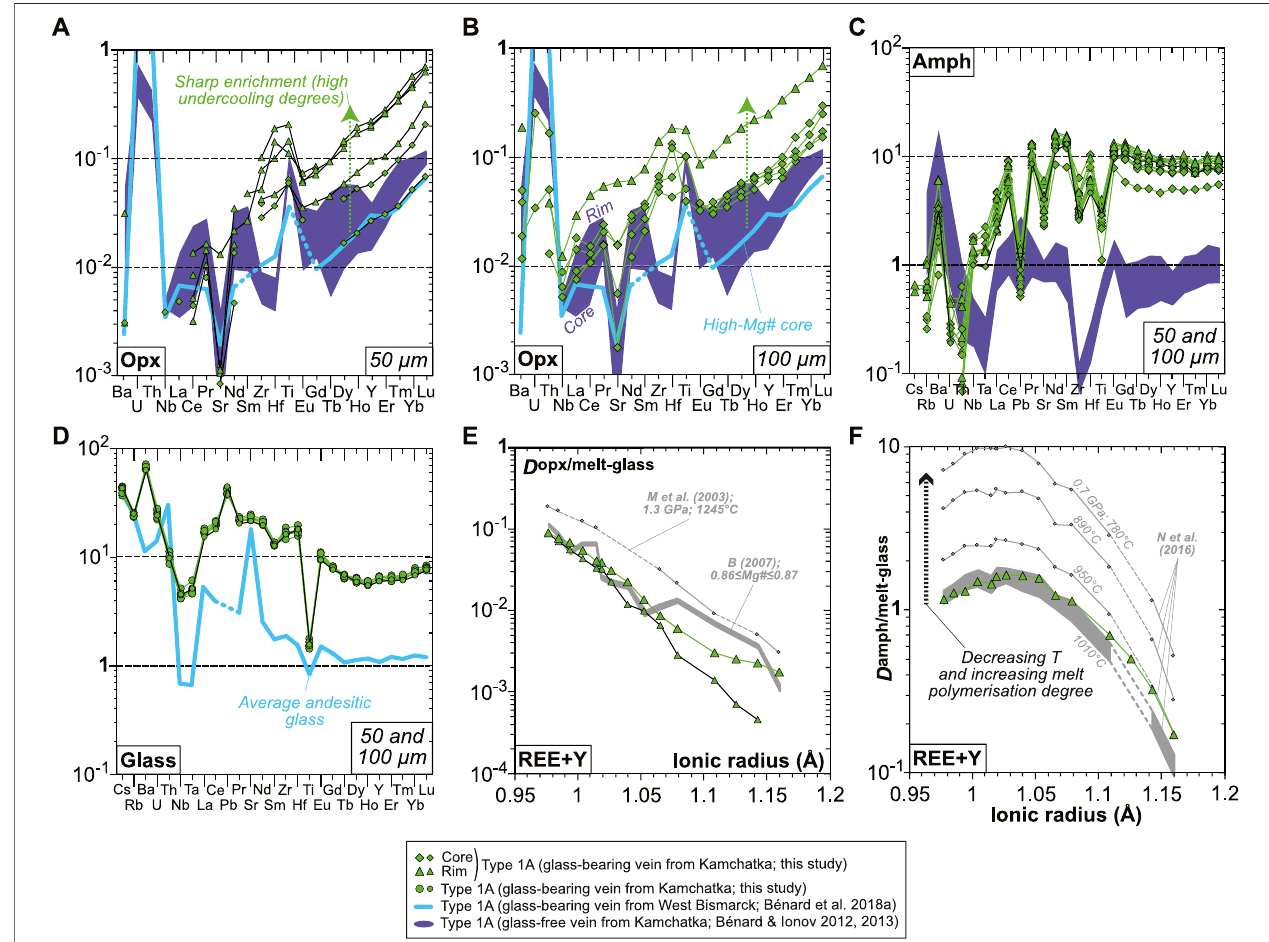
FIGURE 7 | Mineral and glass trace element compositions and partitioning data for the new Kamchatka vein in this study. (A – D) Primitive mantle-normalized (McDonoughandSun,1995)abundancesoflithophiletraceelementsin (A,B) opx, (C) amphibole, and (D) interstitialglass. Orthopyroxenedataacquiredusinga50- μ m laser spot are shown in (A) , while those acquired using a 100- μ m laser spot are shown in (B) . (C) Opx – glass and (D) amphibole – glass REE and Y partition coef fi cients calculated using averages of the data shown in (A – D) . Also shown in (E) are opx-melt partitioning data from the experiments of McDade et al. (2003) and those calculatedusingtheparameterizationbasedonopxMg#fromBédard(2007).Alsoshownin (F) areamphibole – meltpartitioningdatafromtheexperimentsofNandedkar et al. (2016).